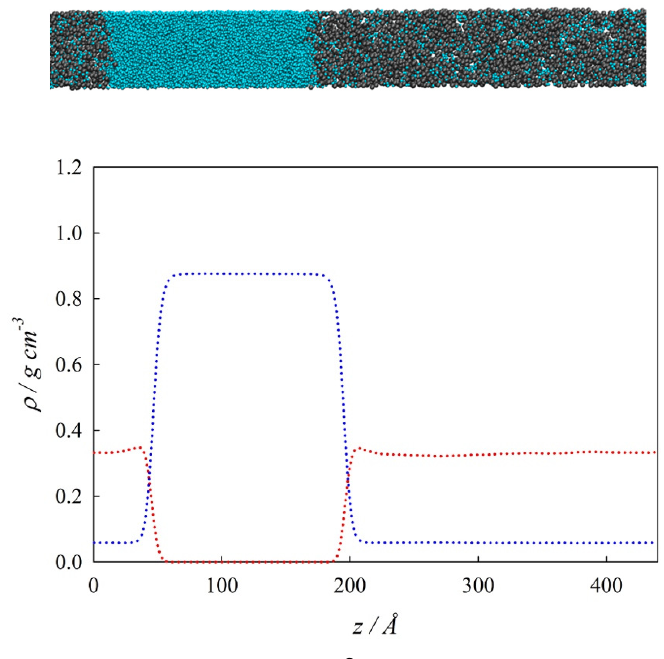
Figure 5. Interfacial concentration distribution along the interfacial region at three di ff erent isothermal conditions. ( a ). 290 K; ( b ). 380 K; ( c ). 485 K. Top: Snapshot: ( • ) water, ( •• ) n -hexane. Bottom: Interfacial concentration profiles, ρ i , along the interfacial region, z. SGT + SAFT-VR Mie EoS